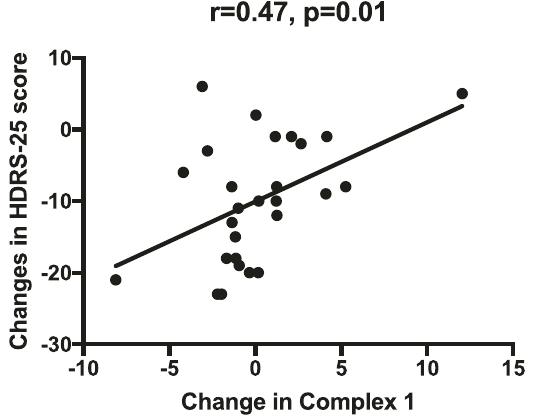
Fig. 2 Change in HDRS-25 scores correlated signi fi cantly with change in Complex I activity between baseline and 8 weeks of SSRI treatment. A negative score indicates a greater decrease over time, delta scores were computed by subtracting the week 8 value from the baseline value for HDRS-25 and Complex I respectively. This correlation was also signi fi cant using nonparametric statistics (rho = 0.4, p =